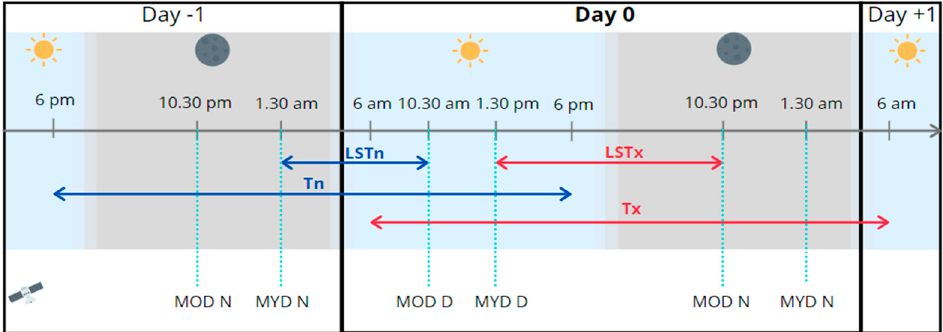
Figure 2. Chronology of acquisition of air temperature (sensors) and land surface temperature (LST) (Terra (MOD) and Aqua (MYD) satellites for (N)ighttime and (D)aytime. Blue arrows indicate calculation intervals of mean daily minimum air temperature (Tn) and LST (LSTn), while red arrows indicate those of mean daily maximum air temperature (Tx) and LST (LSTx).